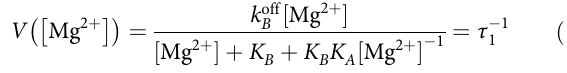
phosphate, which may result in the release of Mg B 2 + during each round of enzymatic turnover. In contrast, Mg A 2 + is likely to remain intact, coordinated by three stationary residues (D119, E129 and L130) at the active site (Supplementary Fig. 8a).